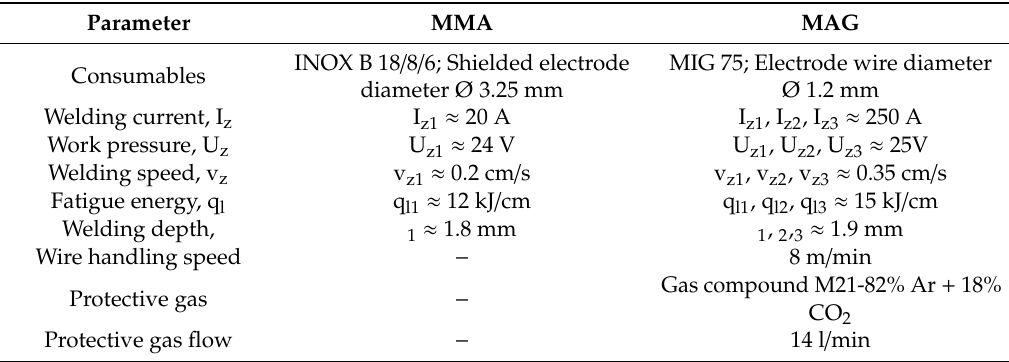
Figure 2. Cross-sections of a metallographic sample with directions and micro hardness measuring spots.